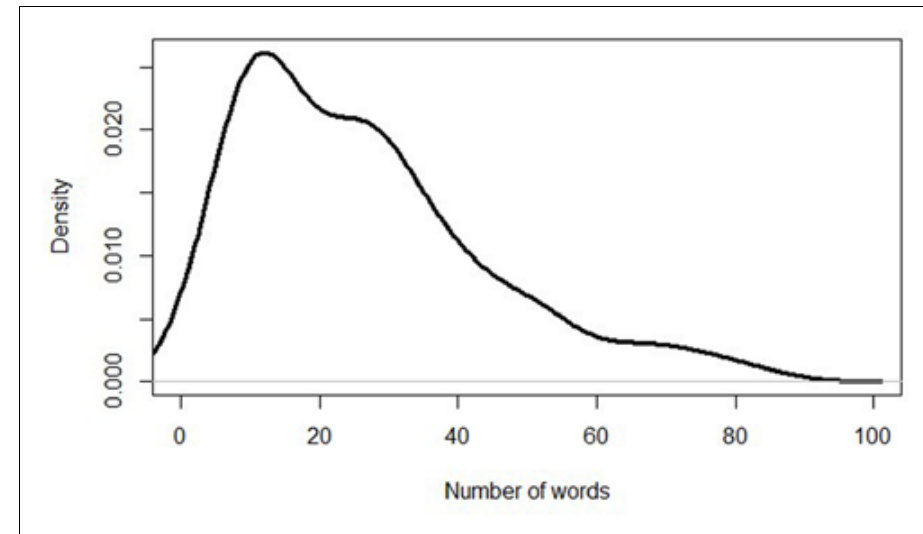
Figure 4: Density plot of number of words per argument (N =